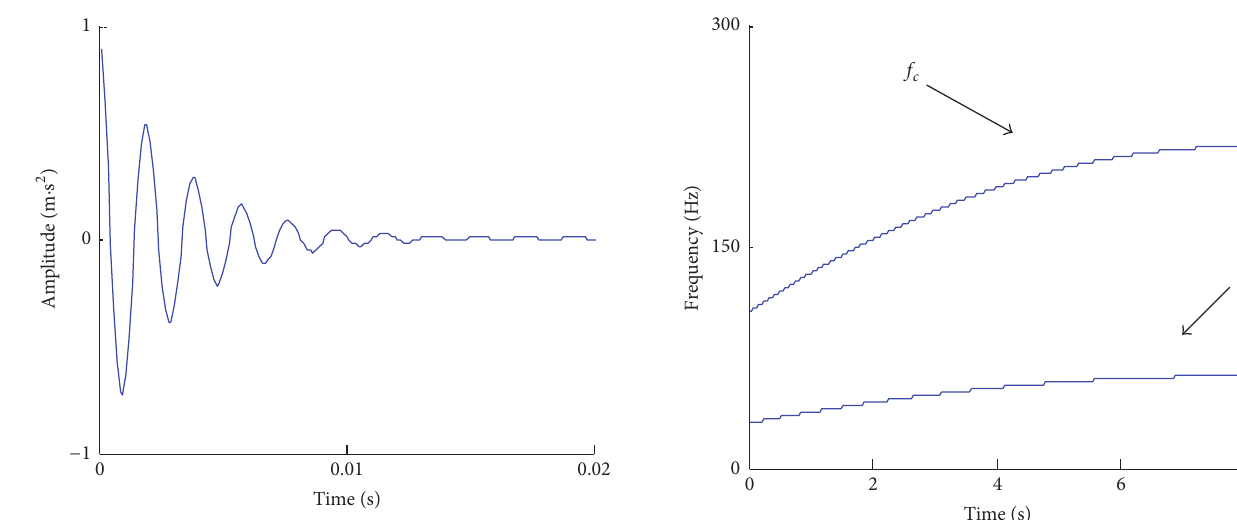
sampling data 𝑥(𝑛) , and then the equiangular resampling signal 𝑥(𝑇 𝑙 ) is gotten. At last, the FFT about the envelope of resampled signal 𝑥(𝑇 𝑙 ) (𝑙 = 1, . . . , 𝐿) is performed to get the order envelope demodulation spectrum.